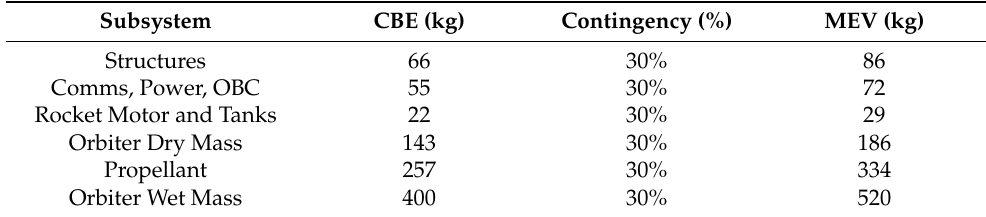
Table 4. Mass breakdown of the